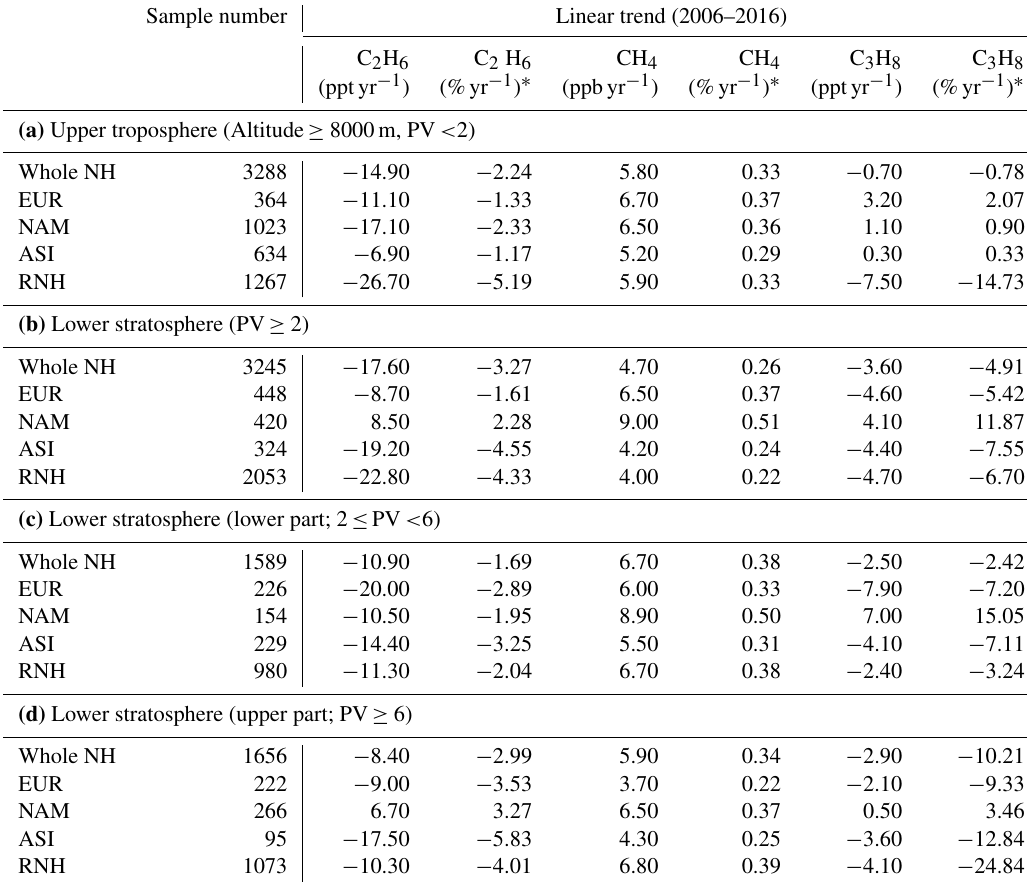
Table 2. Sample number and linear trends of ethane, methane and